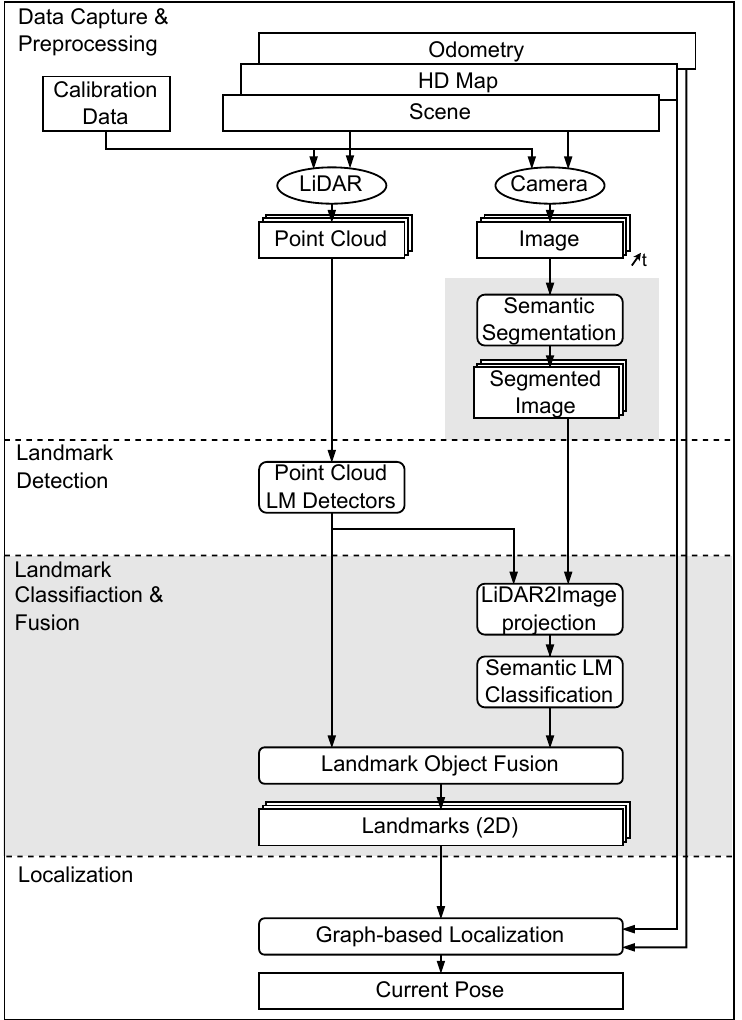
Figure 1. Concept of using semantic information for vehicle self-localization using a high-definition map, diverse sensor types, and the optimization of a pose-graph including landmarks. The two methods described in Section 3 are brought into context with the localization framework. Our impact is highlighted in